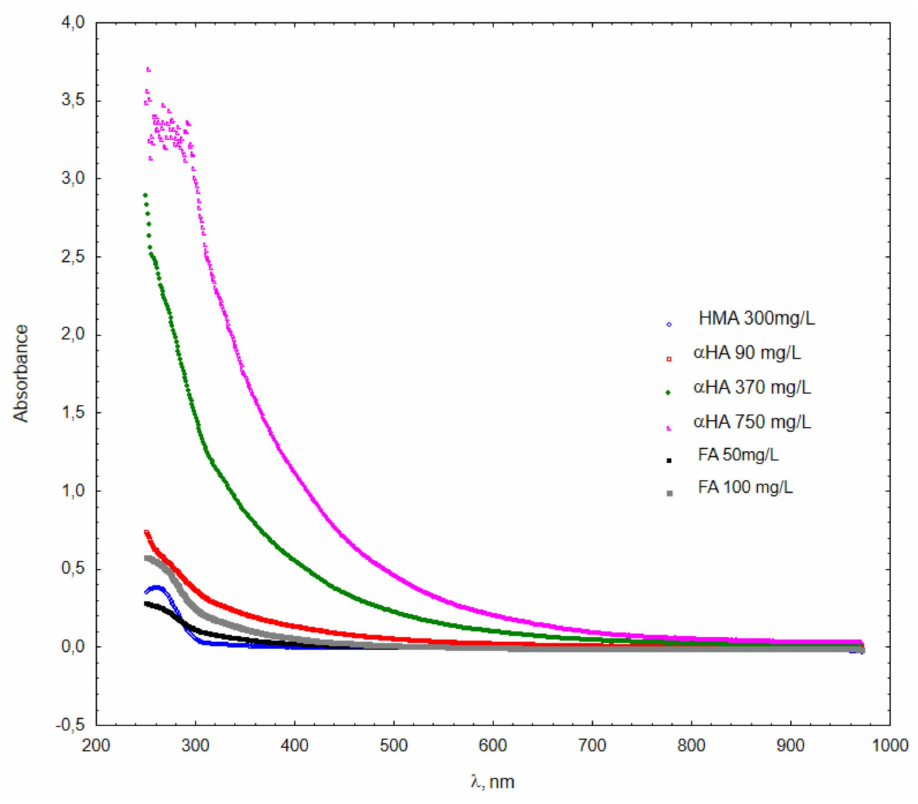
Figure 2. UV-VIS spectra of humus acids extracted from digested sludge of the Kujawy wastewater treatment